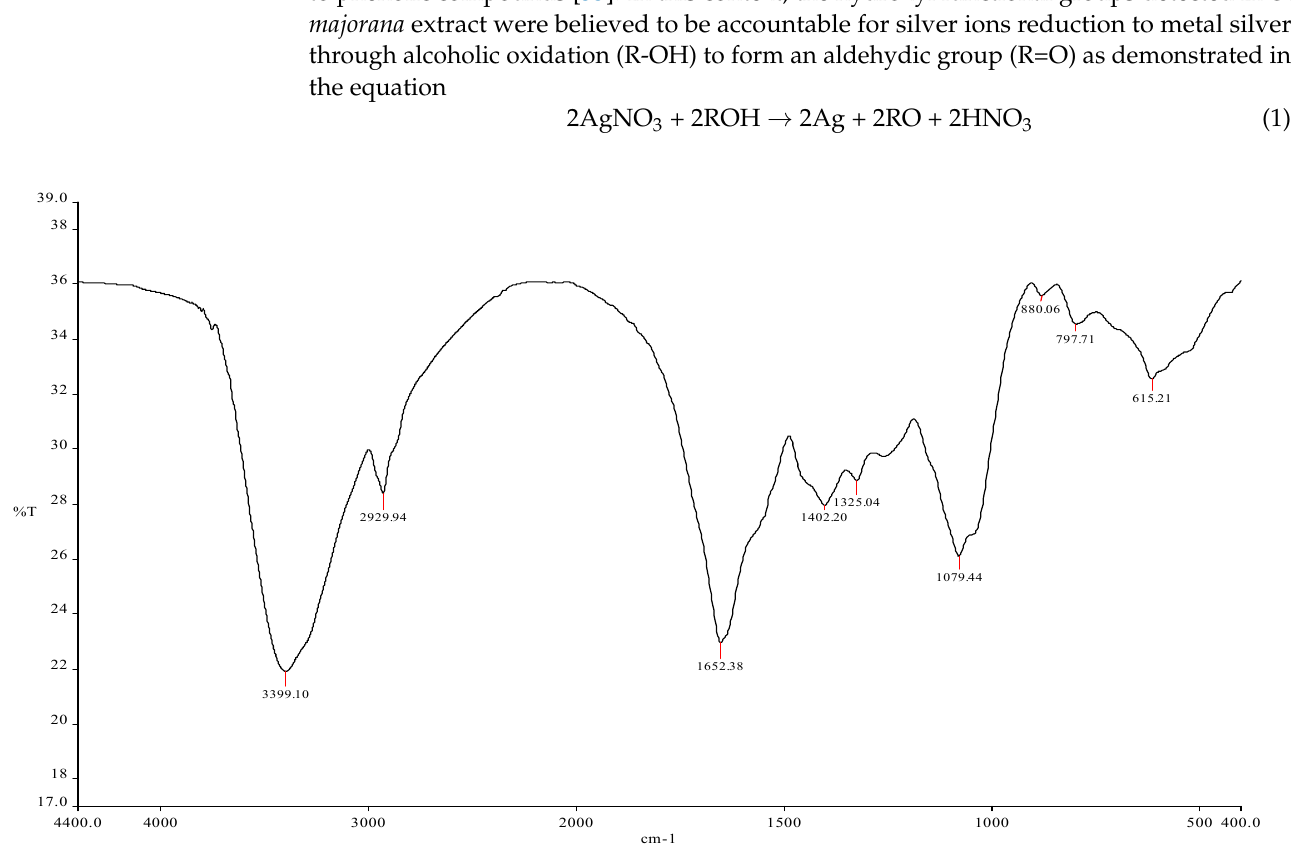
Figure 7. FTIR spectrum of AgNPs synthesized using aqueous extract of Origanum majorana ex- tract.